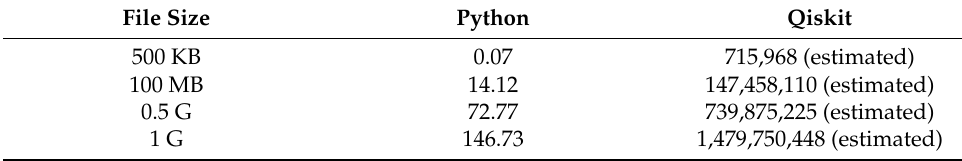
Table 5. Performance time.